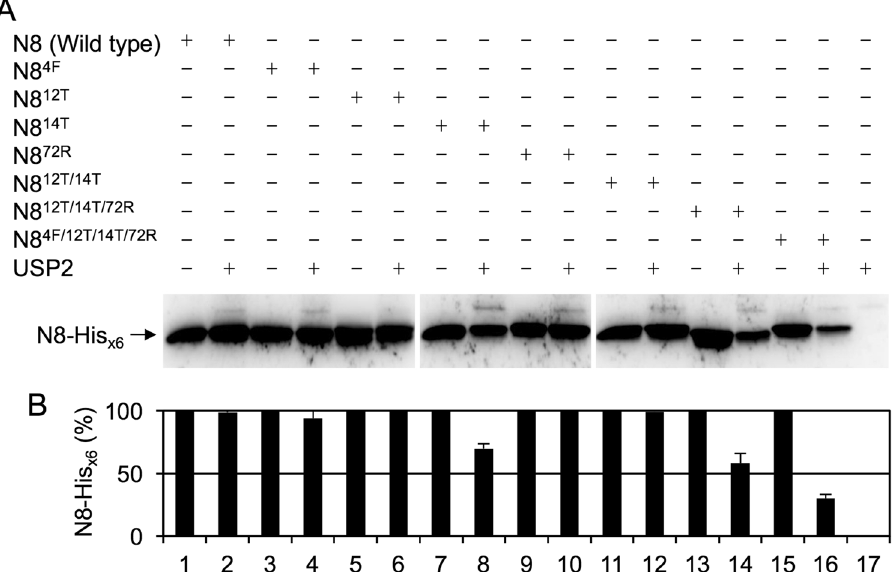
Figure 4. NEDD8 must simultaneously substitute the residues 4, 12, 14 and 72 with the Ub equivalents for efficient hydrolysis by USP2. ( A ) Wild-type NEDD8-His x6 and indicated mutants (13.8 μ M) were incubated with or without USP2 (4.75 μ M) at 37 °C for 60 min. All reactions were terminated by adding 4X SDS-PAGE sample buffer and incubating at 100 °C for 10 min. Samples were separated on 16.6% SDS-PAGE and further analyzed using western blotting with the anti-His x6 tag antibody. Data are representative of three independent experiments. The full-length blots are presented in Supplementary Figure S3. ( B ) The signal intensity of three independent experiments was measured by a densitometer and processed by ImageJ. The results of the measurement were interpreted as a bar graph. Values are means ± S.D. from three independent experiments. The numbers noted at the bottom represent the lane numbers on the western